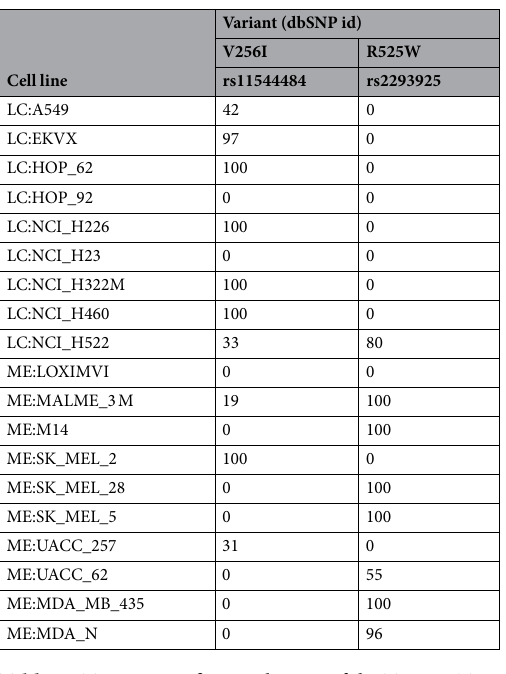
Table 3. Tissue-specific enrichment of the TOP1MT SNP variants in the NCI-60. Numbers in both columns refer to the percentage of reads with that particular variant.